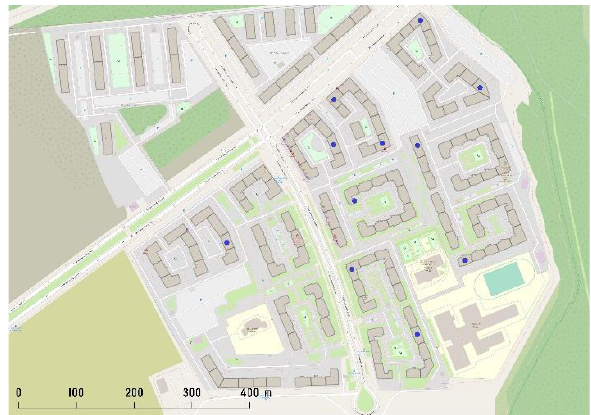
Figure 4 . Distribution of hotbeds in